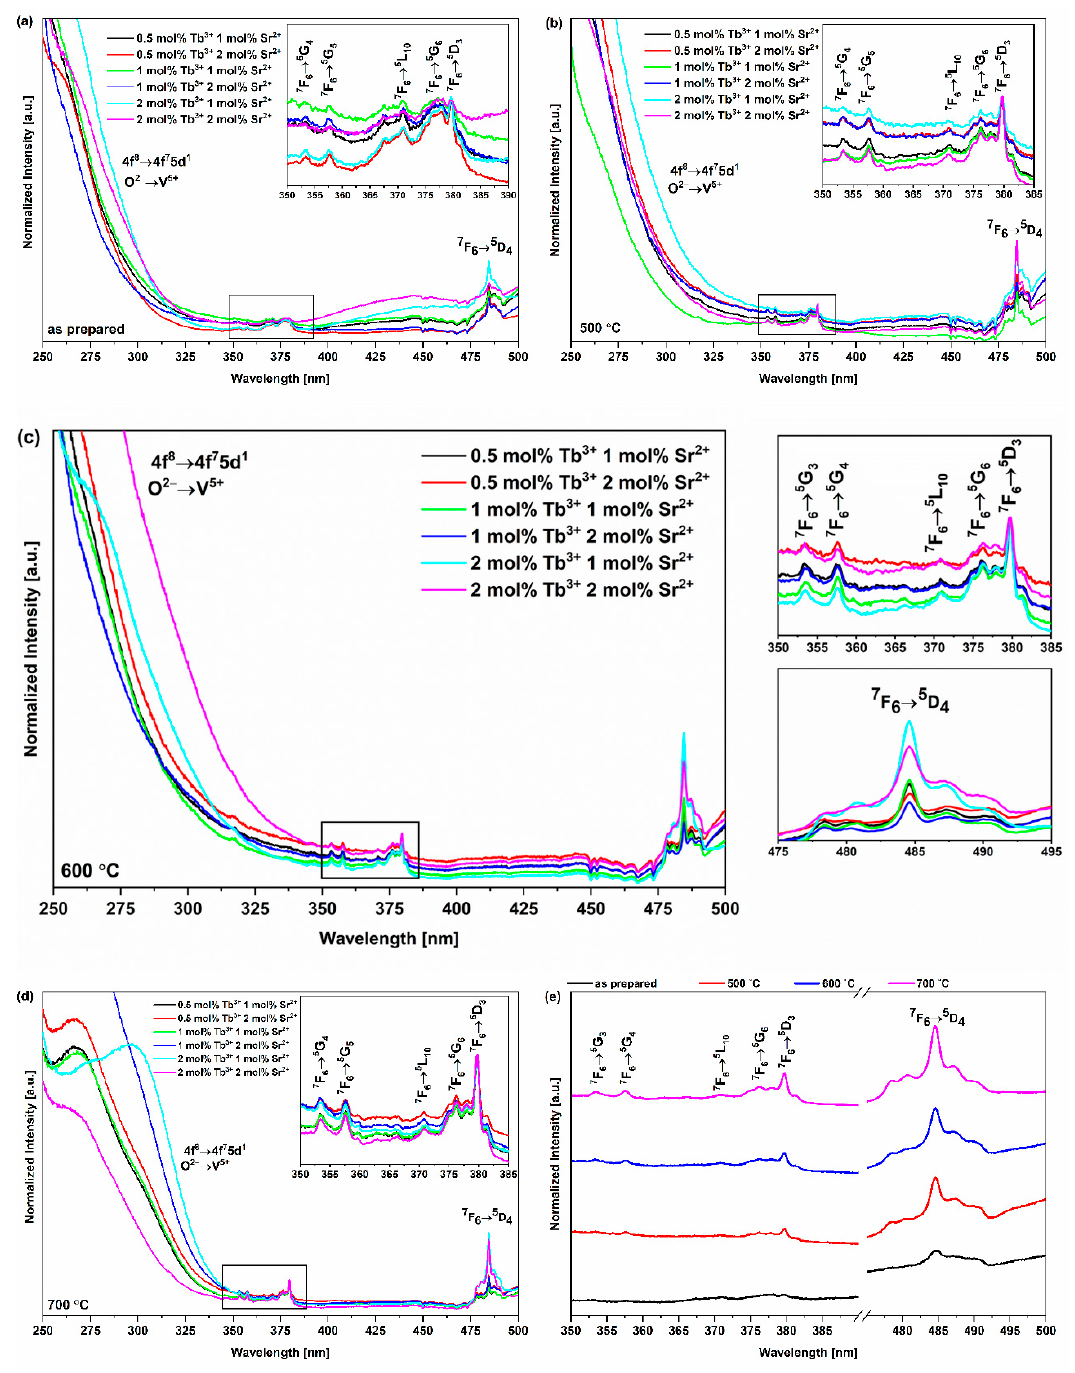
Figure 5. Excitation emission spectra of ( a ) thermally untreated materials (as prepared), ( b ) ma- terials annealed at 500 ◦ C, ( c ) materials annealed at 600 ◦ C ( d ) materials annealed at 700 ◦ C and ( e ) material co-doped with 2 mol% Sr 2+ and 2 mol% Tb 3+ , at an observation wavelength of 545 nm ( 5 D 4 → 7 F 5 transition). The peak visible in the near-UV region originates from CT within the vanadate group (O 2 − → V 5+ ) and/or interconfigurational transitions (4f 8 → 4f 7 5d 1 ) of Tb 3+ ions. The peaks origi- nating from 4f-4f intraconfigurational transitions of Tb 3+ ions represent 7 F 6 → 5 G 4 (353 nm), 7 F 6 → 5 G 5 (358 nm), 7 F 6 → 5 L 10 (370 nm), 7 F 6 → 5 G 6 (376 nm), 7 F 6 → 5 D 3 (380 nm) and 7 F 6 → 5 D 4 (485 nm) transitions. In the visible radiation range of the spectra, there are peaks related to forbidden 4f- 4f intraconfigurational transitions of Tb 3+ ions: 7 F 6 → 5 G 4 (353 nm), 7 F 6 → 5 G 5 (358 nm),